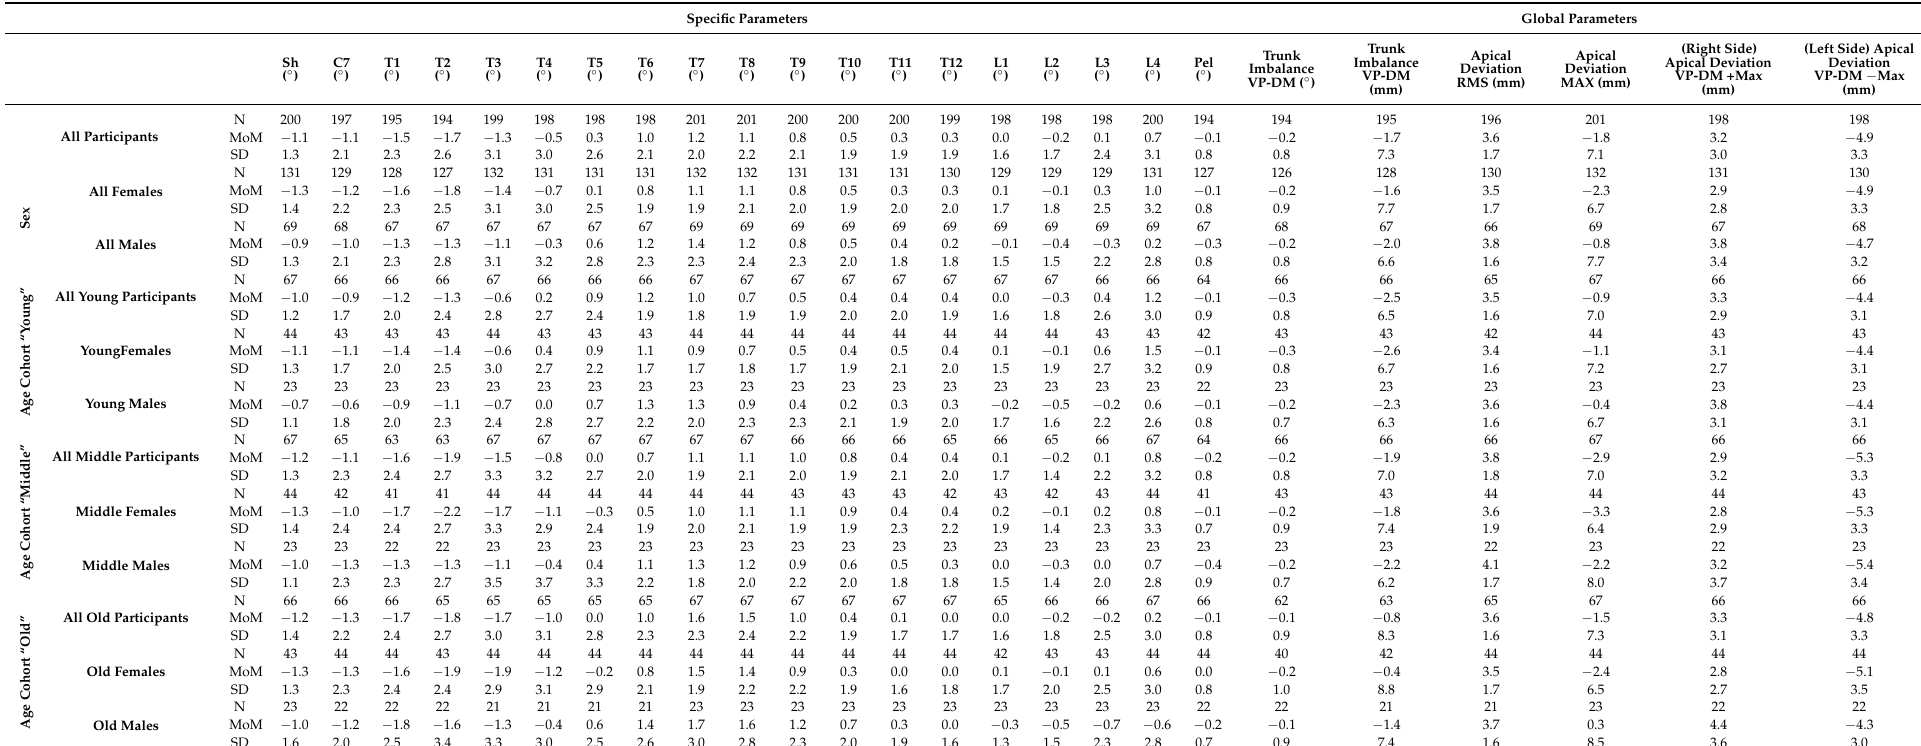
Table 3. Results of the descriptive statistical analyses (MoM ± SD) of the spinal parameters in the coronal plane.